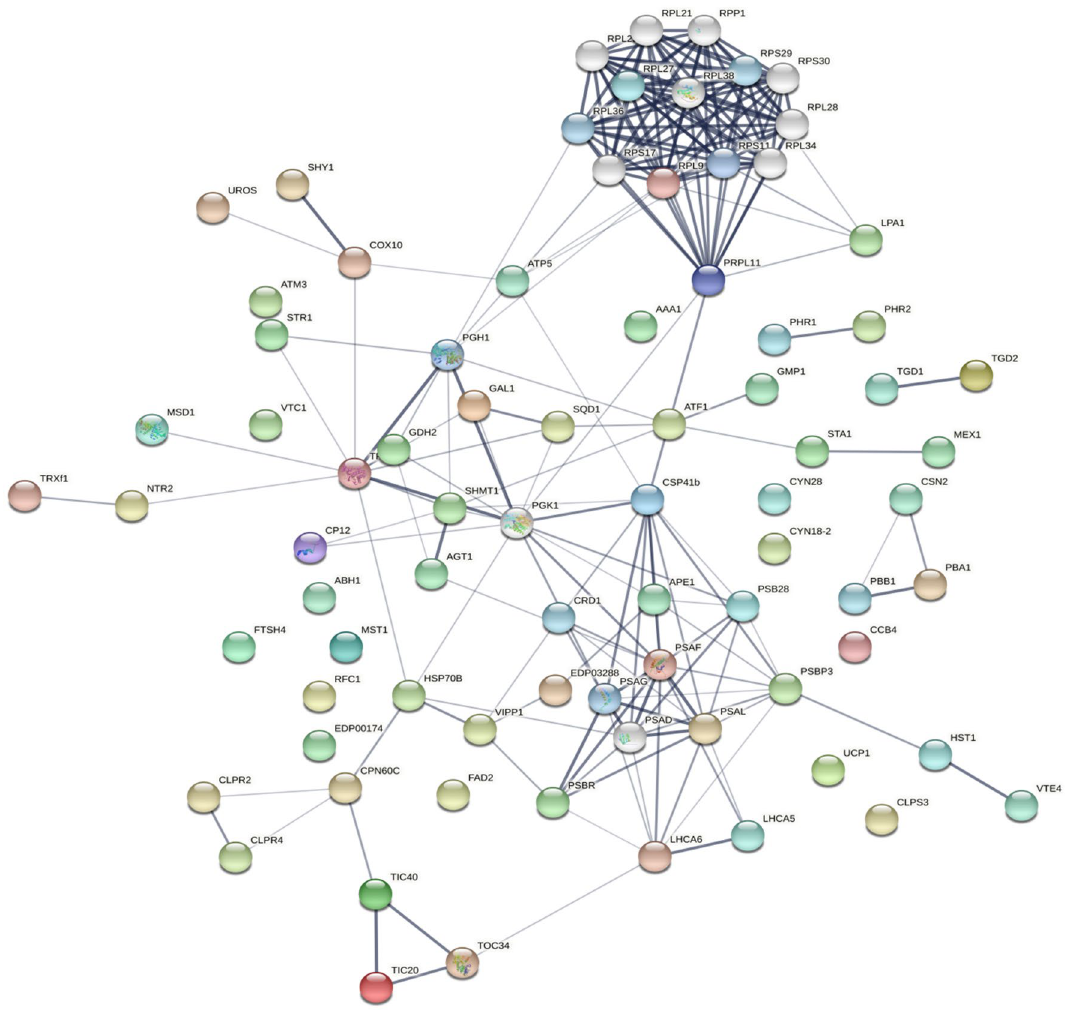
Figure 4. The protein–protein interaction (PPI) network in D. salina constructed using STRING database. The abbreviations of protein names are referred to Supplementary Table